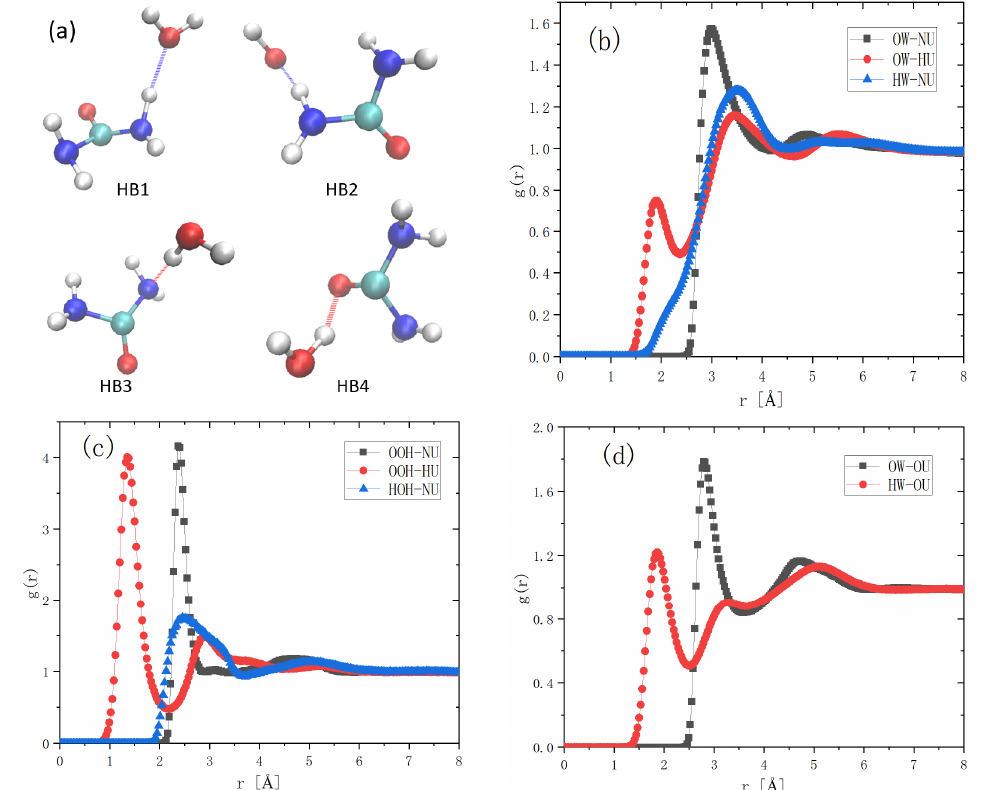
Figure 7. Schematic representation of the four important hydrogen bonds that urea forms with water and OH − ( a ). The colors of the four atoms C, H, O and N are cyan, white, red and blue, respectively. RDF distributions between the atoms of urea and H 2 O/OH − in trehalose LiOH urea aqueous solution ( b – d ).